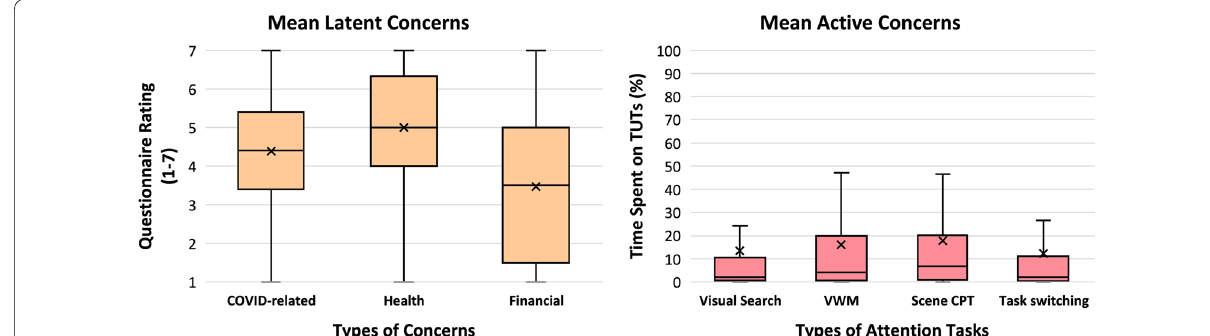
Fig. 3 Left: Box and whisker plot of ratings on survey questions assessing latent concerns regarding COVID-19. Average across all five items is presented on the left, average of the three health-related items is presented in the middle, and average of the two finance-related items on the right. Scores closer to 7 indicate more severe concerns, scores closer to 1 indicate very low levels of concern, and scores around 4 indicate moderate levels of concern. Each box plots data from the first quartile to the third quartile. Right: Box and whisker plot of the percentage of time spent on general task-unrelated thoughts during the four attention tasks: Visual search, visual working memory, scene CPT, and task switching. Ratings closer to 100% indicate more time spent mind wandering, and ratings closer to 0% indicate full attention on the task. Each box plots data from the first quartile to the third